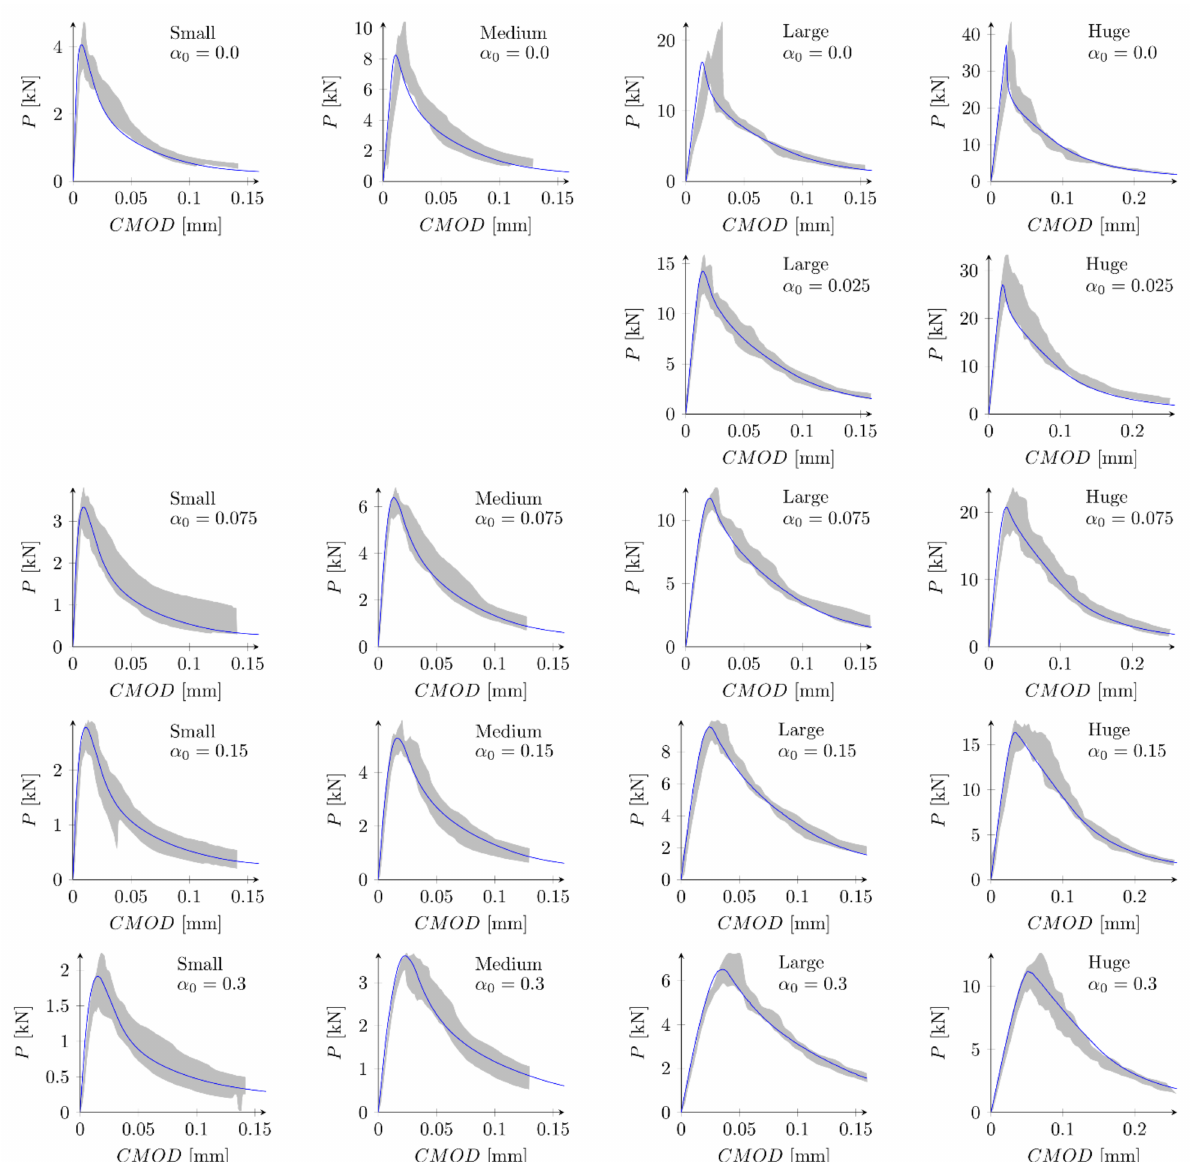
Figure 10. Experimental and numerical force—crack mouth opening displacement curves for bilinear softening and set S7: f t = 5.2 MPa, G f = 42 N/m, b = 0.5 cm, β 0 =